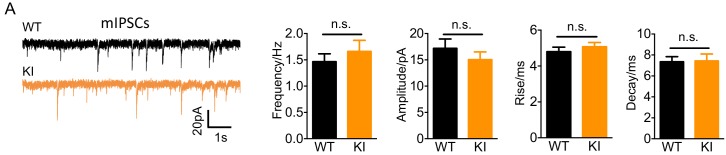
Nxph4-3xFLAG KI mice showed normal mIPSC.(A) Miniature IPSCs recorded from the KI and WT cerebellar granule cells. From left to right: representative mIPSC traces, mean mIPSC frequency, amplitude, rise, and decay (n = 11–14 cells; 5mice). Data are presented as mean ± SEM. n.s., not significant; by t test.